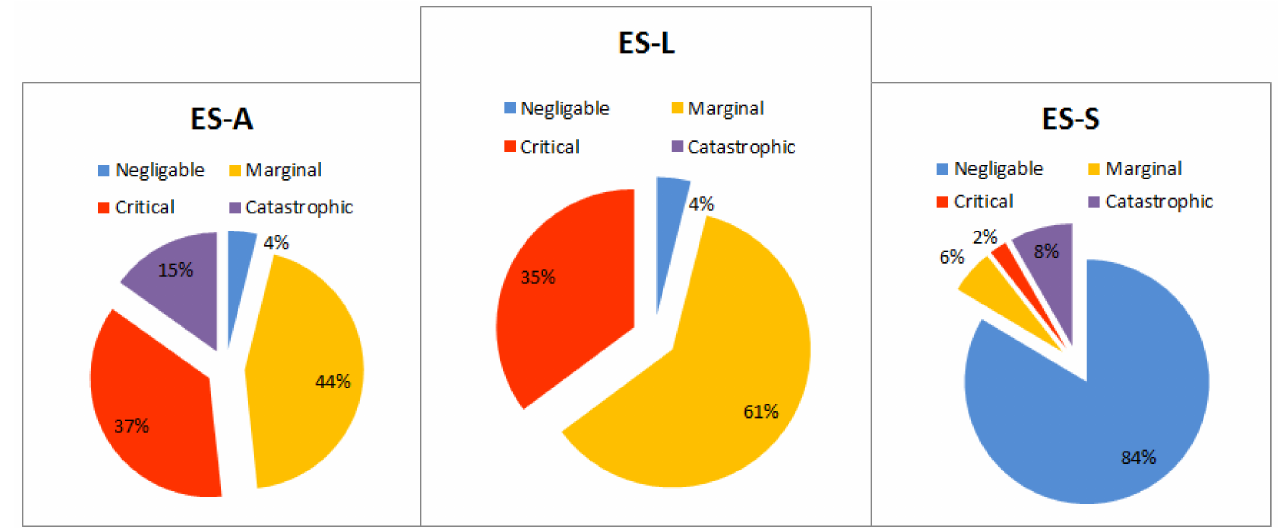
Figure 2. Result graphs based on maneuvering difficulties for 330 m Bulk Carrier.